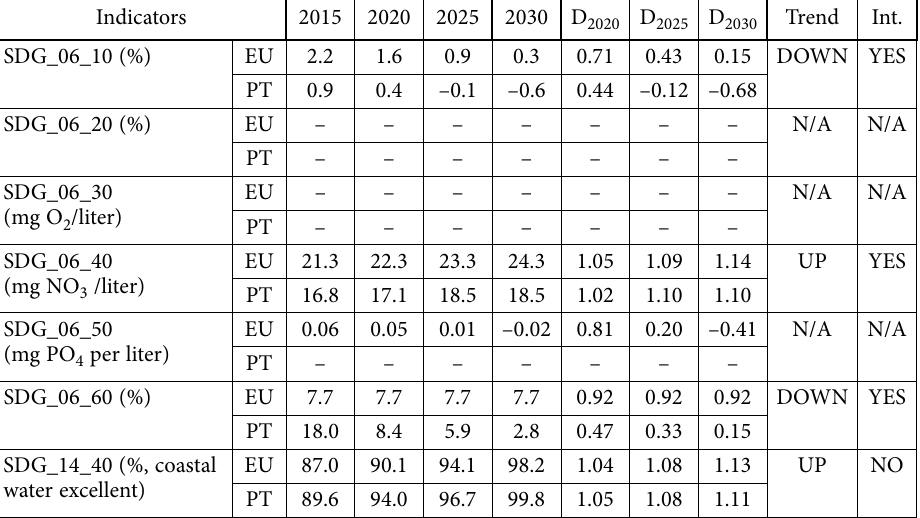
Table 7. SDG 6 – Clean water and sanitation